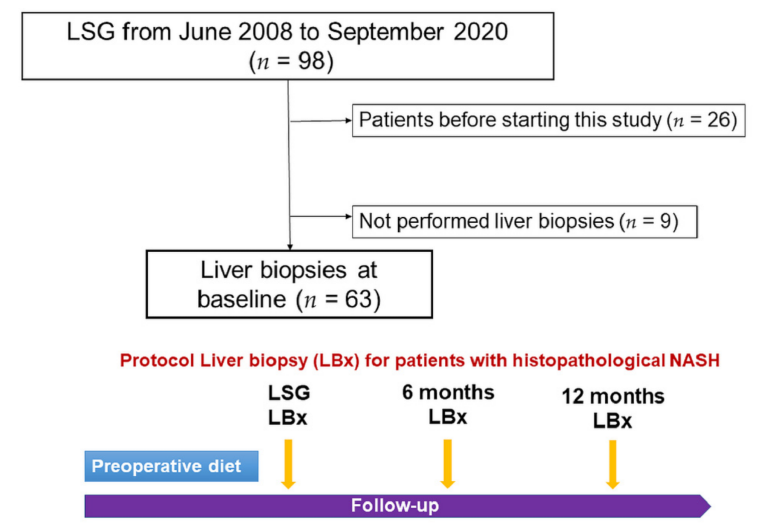
Figure 2. A flowchart of the eligible patients included in this study. Protocol intraoperative liver biopsy was performed on patients with histopathological NASH. Abbreviation: LB, liver